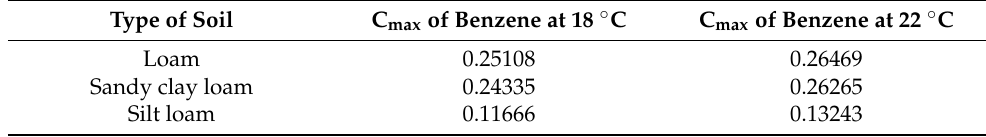
Table 2. The maximum concentration mg/L into the water table set at a depth of 100